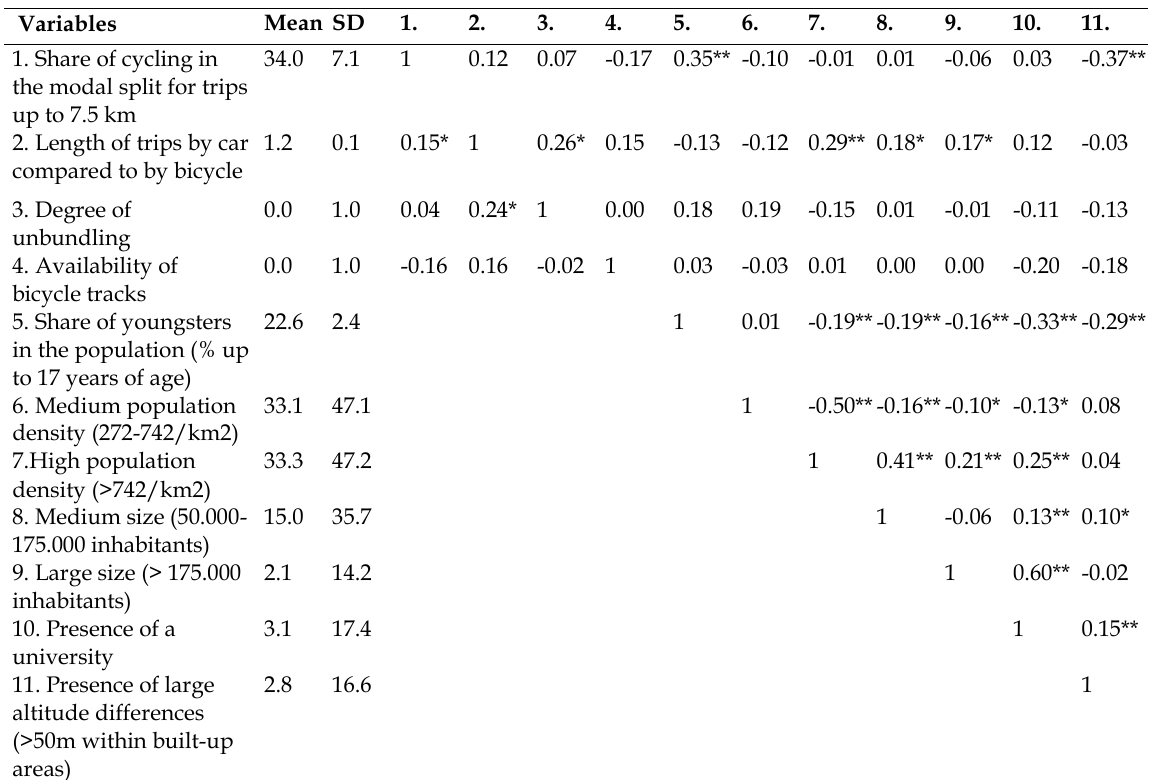
Table 5. Descriptive Statistics for the Variables Used in the Bicycle